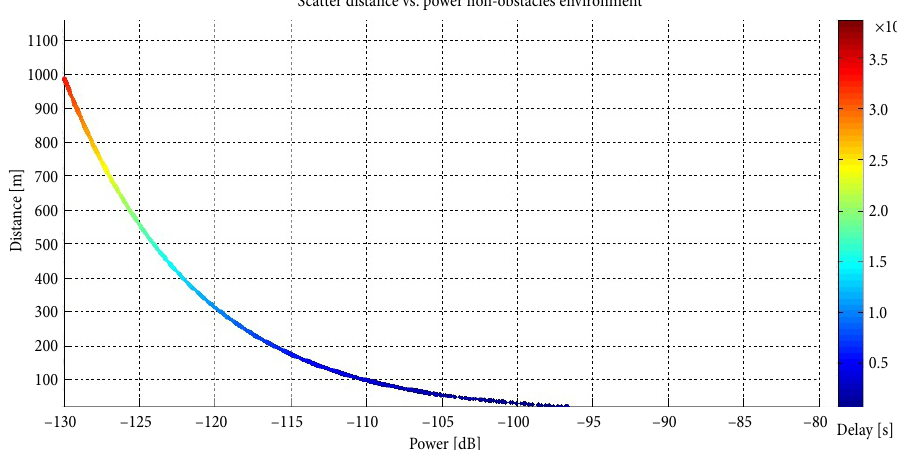
Scatter distance vs. power non-obstacles environment